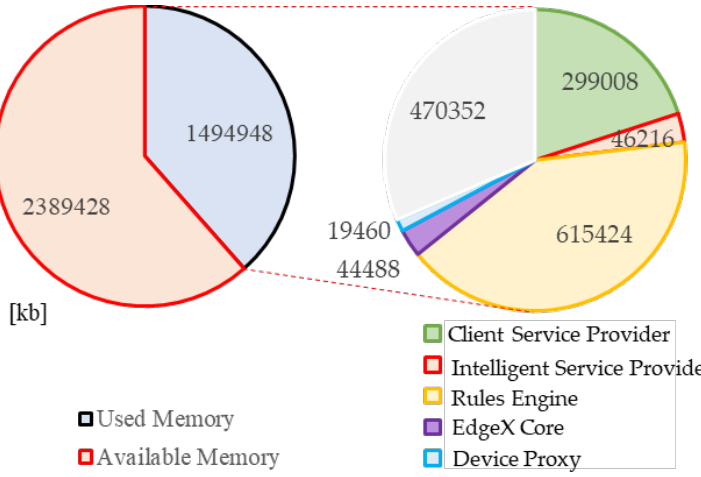
Figure 15. Proposed edge gateway memory usage.